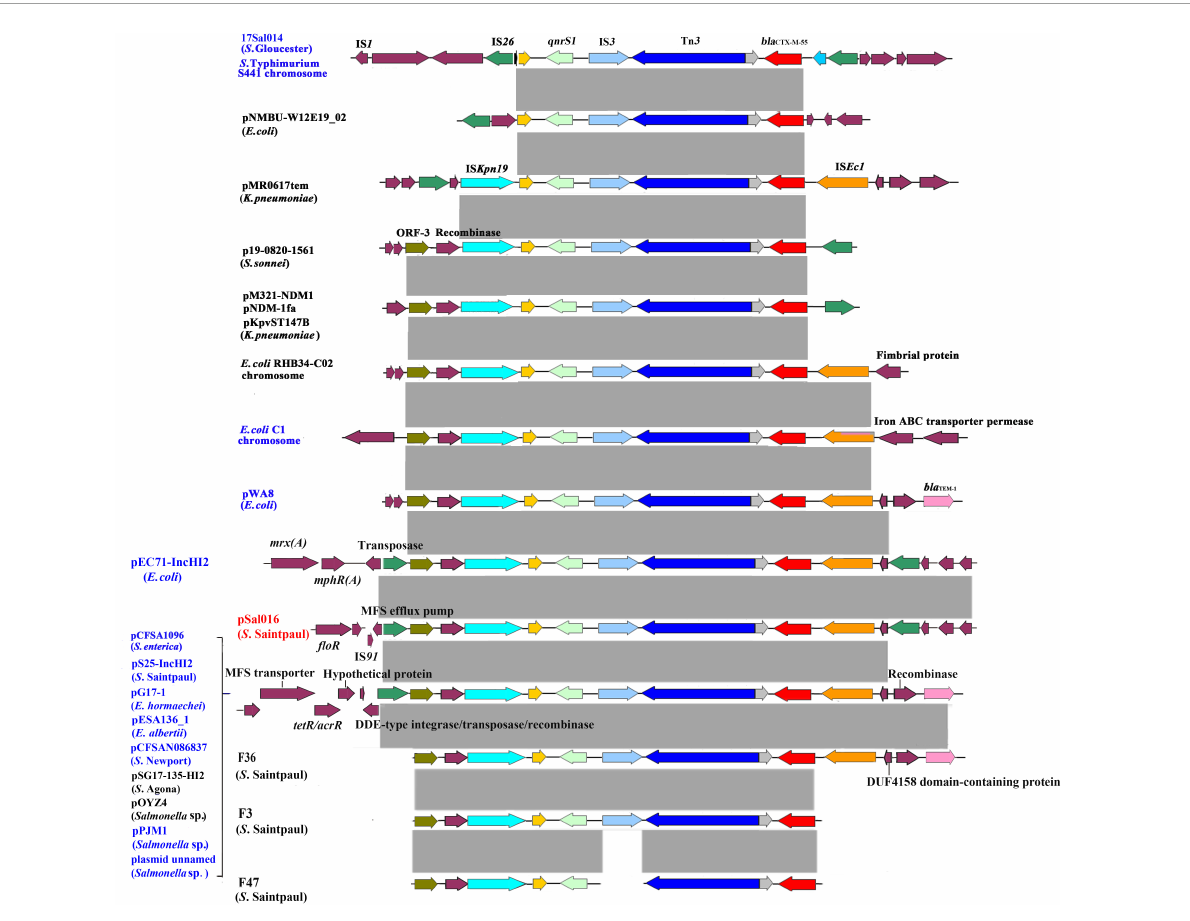
FIGURE2 Genetic environment of bla CTX − M − 55 and qnrS1 genes from S . Saintpaul isolate 16Sal016 and different bacterial species. The arrows indicate open reading frames. Light gray shading denotes homology regions. Strains from China are in blue font.